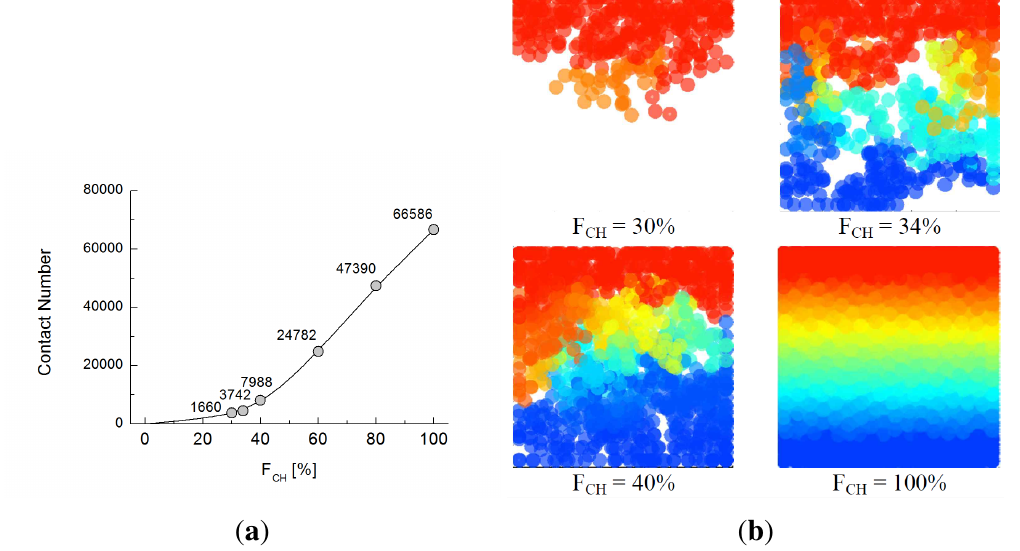
Figure 12. ( a ) Contact number along the volumetric fraction at Case 1; ( b ) connected chrome particles from the top to bottom boundary at different volume fractions for Case